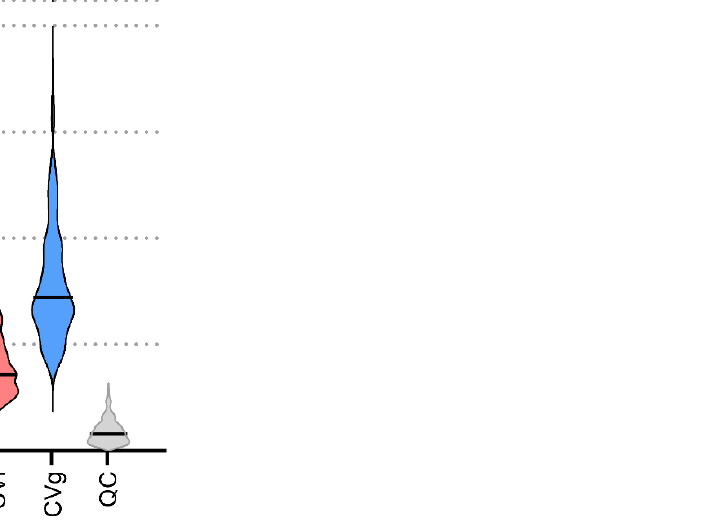
Figure 4. Overview of the variability (CV, %) for 240 detected lipids after lnPQN (natural logarithm with probabilistic quotient normalization) transformation. Quality control samples (QC), intraindividual (CVi), and group variability (CVg). Black lines: medians.